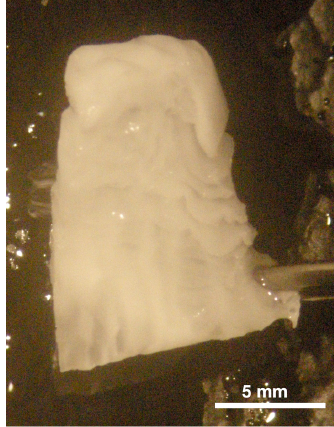
Figure 1. Light micrograph of 700 μ m thick PCL (poly ( ε ‐ caprolactone)) electrospun ‐ nanofiber scaffold.